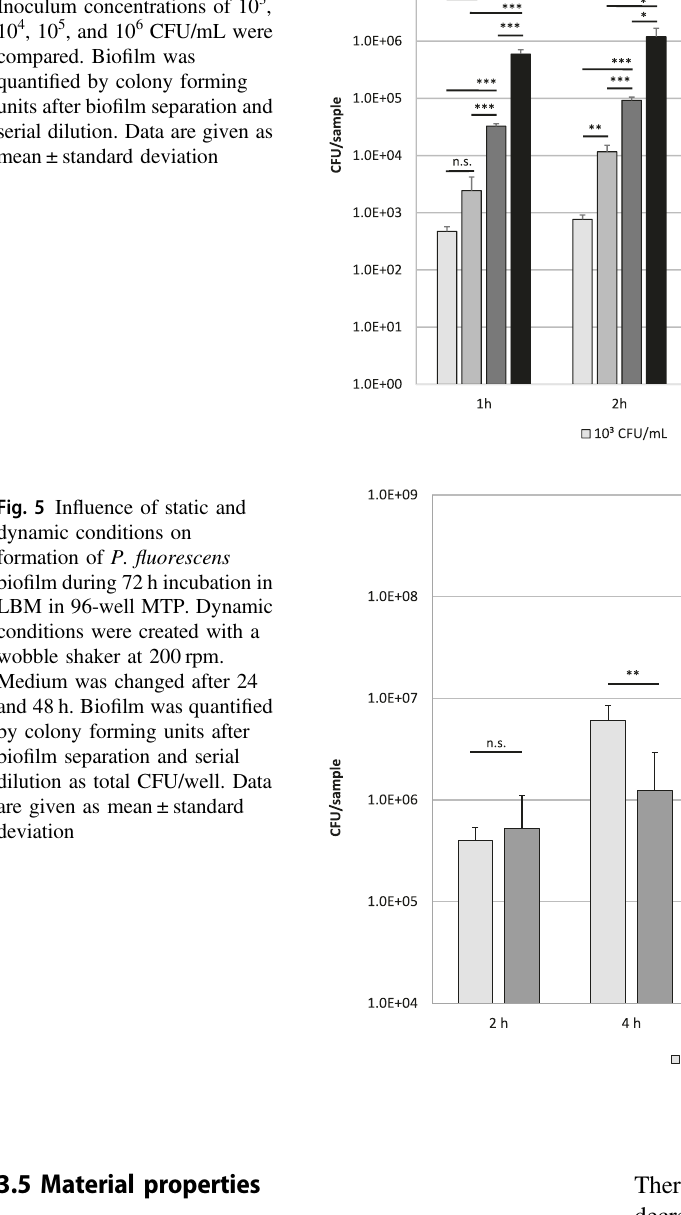
Fig. 4 In fl uence of inoculum concentration on bio fi lm formation of P. fl uorescens during 72 h incubation in LBM on boro fl oat coverslips. Inoculum concentrations of 10 3 , 10 4 , 10 5 , and 10 6 CFU/mL were compared. Bio fi lm was quanti fi ed by colony forming units after bio fi lm separation and serial dilution. Data are given as mean ± standard deviation